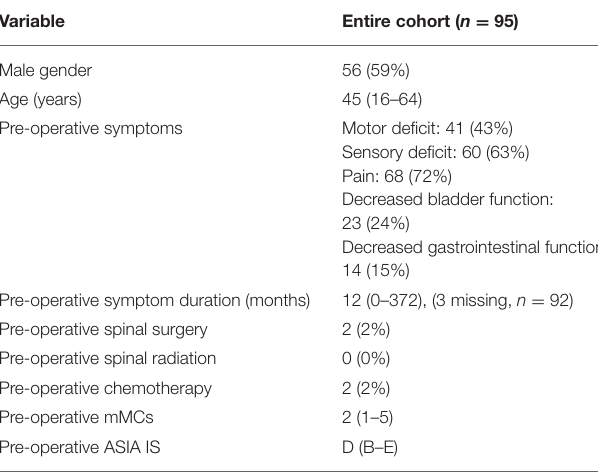
was held open by sutures. The arachnoid was dissected sharply, and the tumor area was exposed.